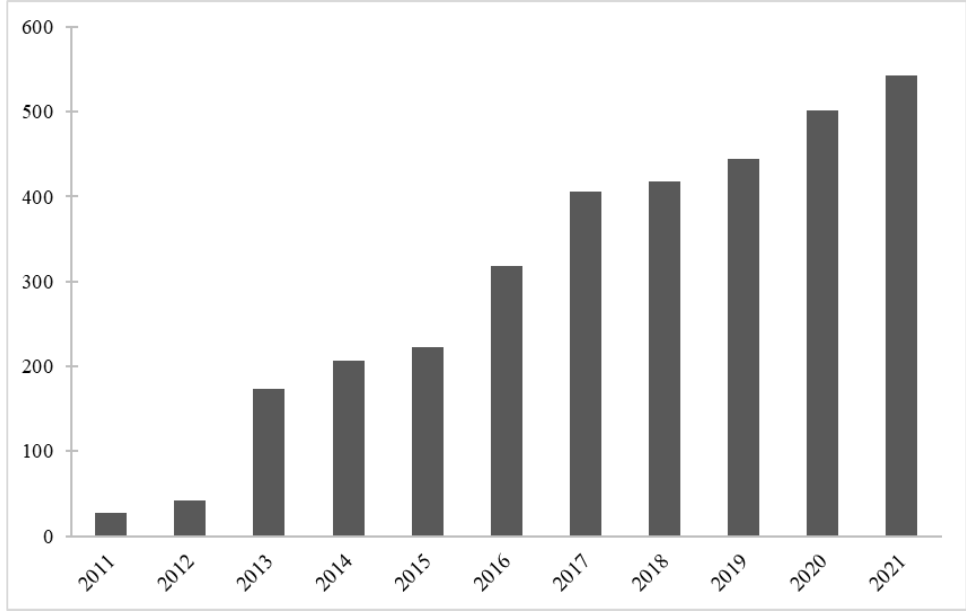
Figure 3. Publications per year on “graphene” in the field of biomaterials. Data retrieved from Web of Science. Table 1. Antimicrobial activity of non-modified graphene